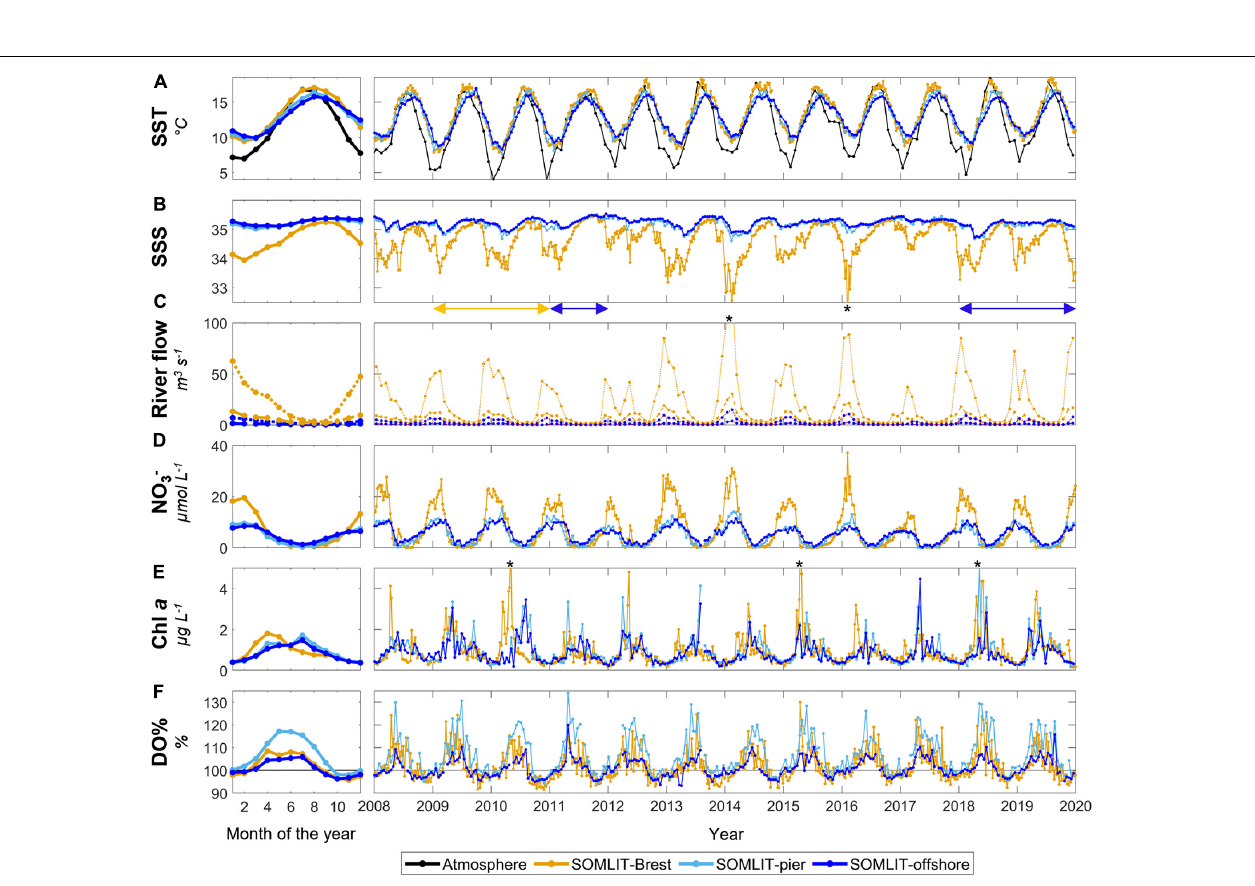
FIGURE 3 | Monthly mean climatology for (A) sea surface temperature (SST, ◦ C), (B) sea surface salinity (SSS), (C) river flow (m 3 s − 1 ), (D) nitrate ( µ mol L − 1 ), (E) Chl a ( µ g L − 1 ), and (F) oxygen saturation (DO%, %) at SOMLIT-Brest (orange), SOMLIT-pier (light blue), and SOMLIT-offshore (dark blue), from January 2010 to December 2017, and the associated time series of weekly/bimonthly data from January 2008 to January 2020. (C) Brest river flow is shown in orange and Roscoff river flow is shown in blue. The black line represents the atmospheric temperature ( ◦ C). The monthly mean climatologies were computed based on complete years acquired from January 2010 to December 2017. Salinity values down to 32.5 and 31.7 (out of the figure range and indicated by black asterisks) were observed in February 2014 and February 2016, respectively. In February 2014, river flow values up to 130 m 3 s − 1 were observed in the Aulne river (indicated by a black asterisk). Chl a concentrations of 5.9, 6.3, and 5.2 µ g L − 1 were observed in May 2010, April 2015, and May 2018 (indicated by a black asterisk), respectively. Blue double-arrows below the SSS plot represent the period of sampling in the Roscoff rivers, and the orange double-arrow represents the period of sampling of the Brest